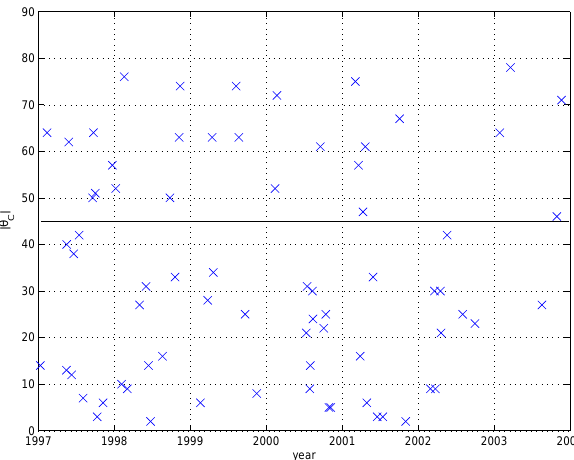
Fig. 6. Inclination angle θ C with respect to the ecliptic plane.